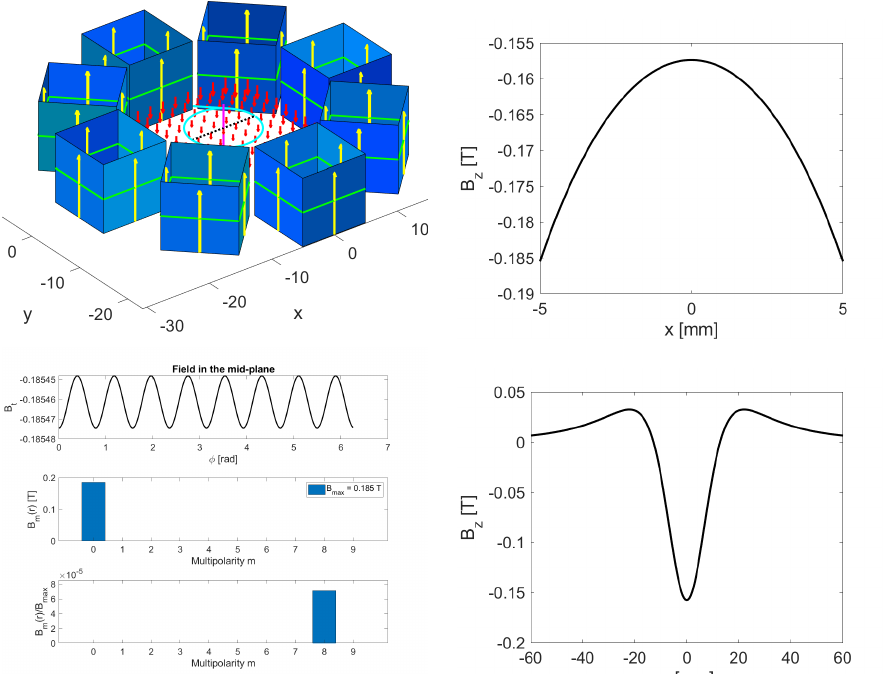
Figure 4. Top left: the eight cubes for an axial solenoid are shown as hollow blue cubes and the magnetic field by red arrows. Top right: the axial field B z along the black dotted line shown on the top-left image. Bottom right: B z along the axis perpendicular through the center of the ring. Bottom left: the axial field B z on the cyan circle (upper panel), the dominant field harmonic, here constant (middle); and the relative strength for the unwanted harmonics.